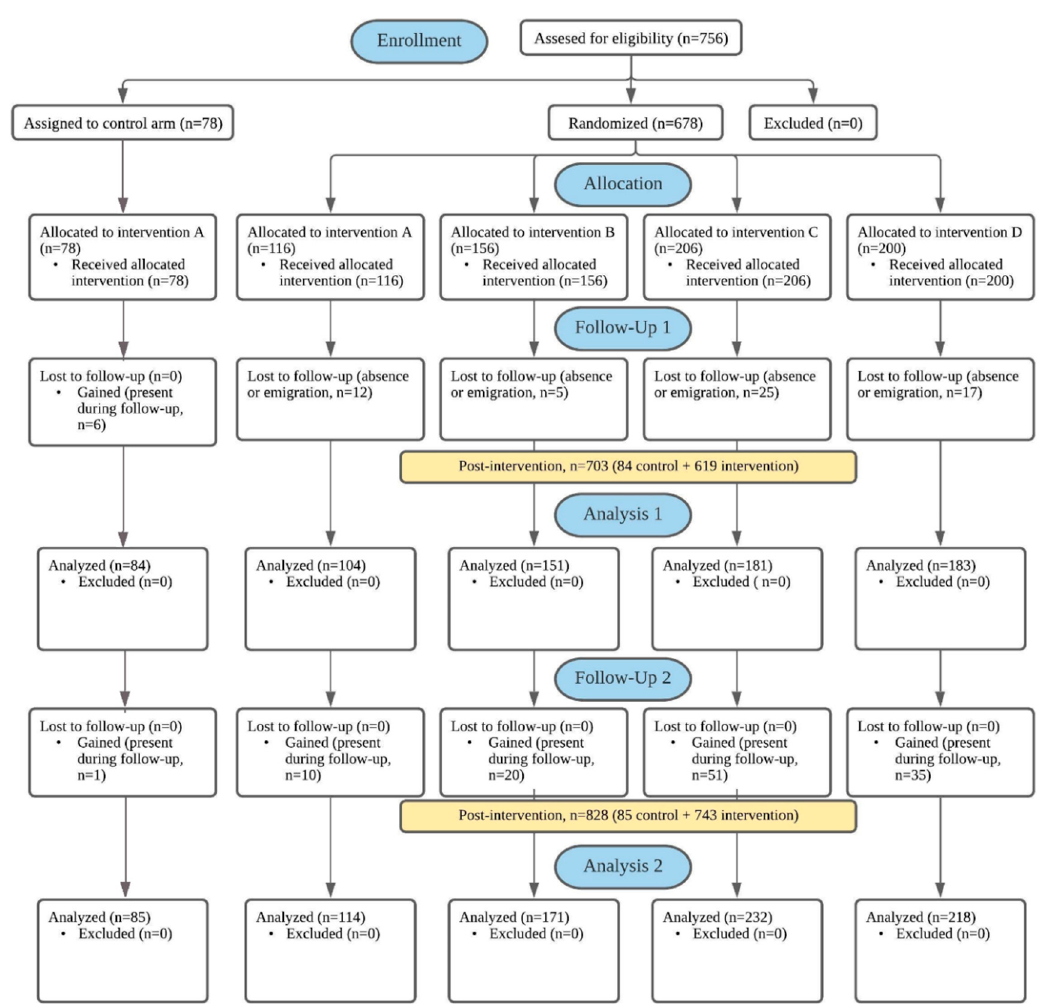
Figure 3. Assignment of participants and completed follow-up: flow diagram based on CONsolidated Standards of Reporting Trials (CONSORT) [28].